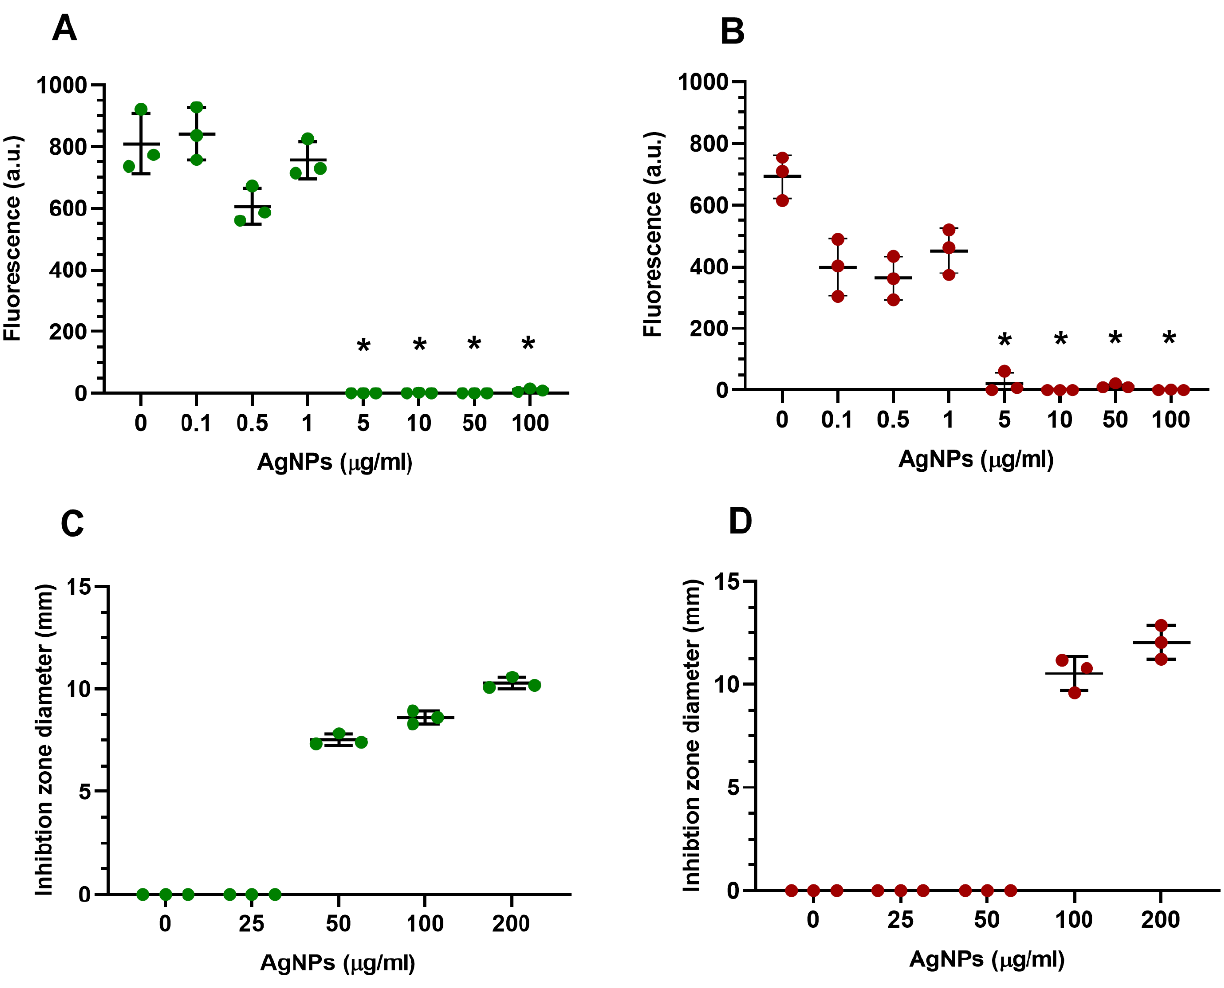
Figure 8. Top; Graphs the bacterial viability by Prestoblue ® at 24 h. ( A ) E. coli . ( B ) S. aureus * < 0.0001. Bottom: Graphs showing inhibition zones of E. coli and S. aureus of different concentrations of AgNPs encapsulated in GelMA constructs. ( C ) E. coli . ( D ) S. aureus .